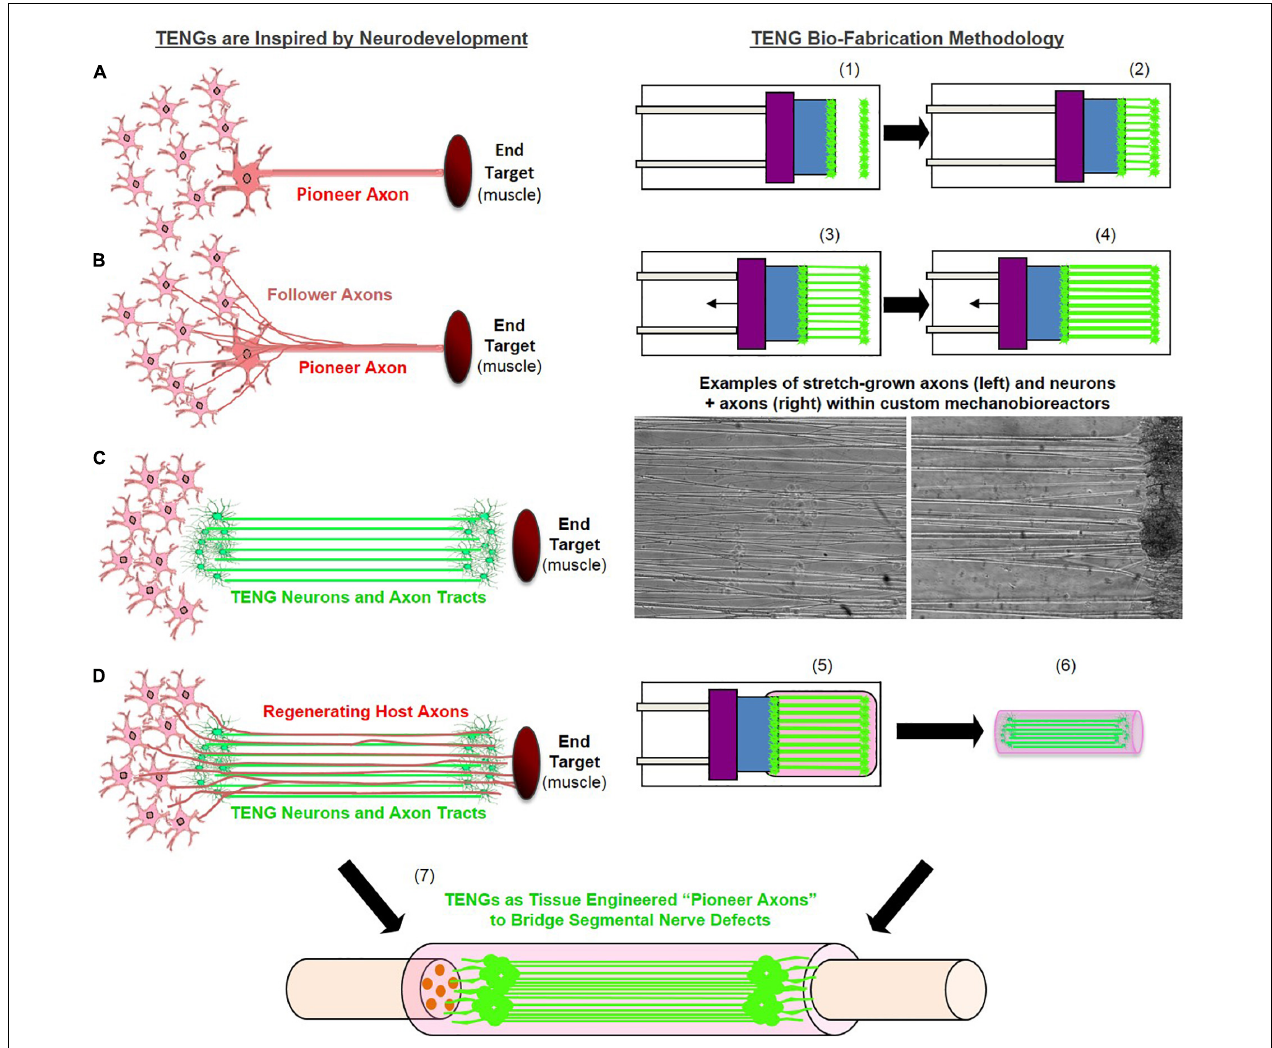
FIGURE 1 | Tissue Engineered Nerve Graft (TENG) Inspiration, Biofabrication, and Surgical Implementation. LEFT: TENGs are inspired by axonal pathfinding during nervous system development, where (A) “pioneer axons” reach a target first, and then (B) serve as a physical guide for “follower axons” to reach that target. TENG axons are effectively (C) tissue engineered “pioneer axons,” thereby functioning as a (D) living scaffold to direct and target regenerating host axons across segmental nerve defects. RIGHT: TENGs are biofabricated in custom mechanobioreactors via the process of axon “stretch-growth.” Fully formed TENGs – comprised of longitudinally aligned axons encased in a collagenous matrix and rolled into a tubular form – are used to physically bridge segmental defects in peripheral nerve. Briefly, (1) Primary DRG neurons are plated in custom mechanobioreactors. (2) Traditional axon outgrowth integrates two neuron populations. (3) A computer-controlled micro-stepper motor is engaged to gradually separate the two neuron populations, applying mechanical tension to spanning axons. (4) Tension induces axon “stretch-growth,” resulting in increased length, diameter, and fasciculation. “Stretch-growth” occurs for days to weeks at 1–10 mm/day, depending on desired length. (5) Immediately prior to implant, neurons and stretch-grown axons are encased in ECM for stabilization. (6) The ECM containing neurons and stretch-grown axons is “rolled” and transferred into an NGT. (7) NGT containing the cylindrical TENG (neurons/axons embedded in ECM) is then sutured to sciatic nerve to bridge an excised